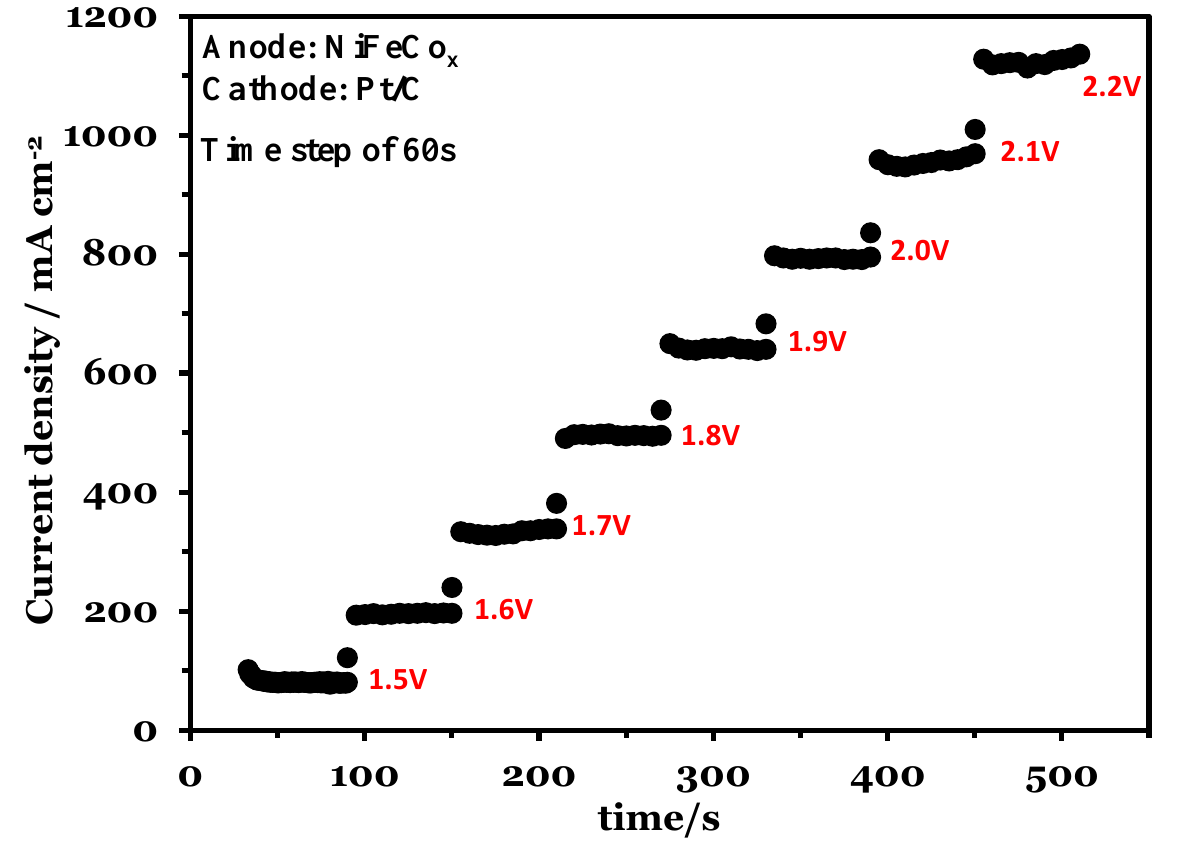
Figure 7. Chronoamperometry at a voltage range of 1.5 to 2.2 V, Pt/C was used at the cathode and NiFeCoO x was used at anode.